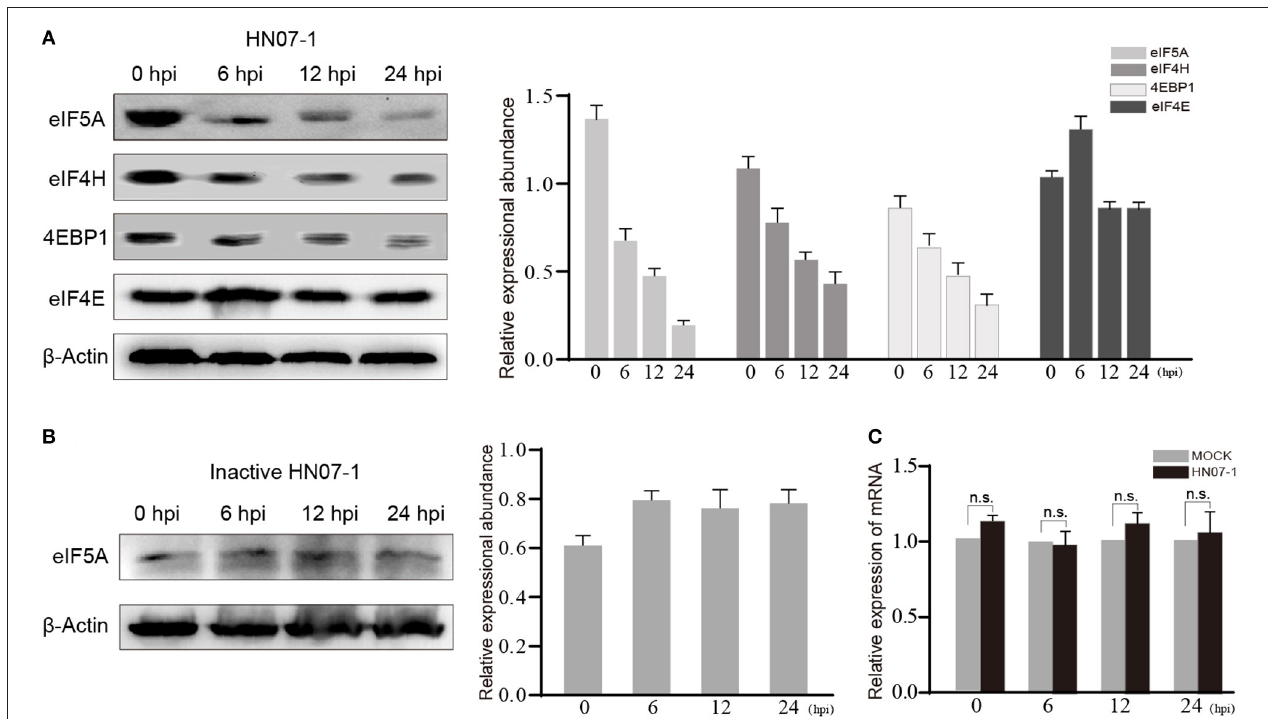
FIGURE 6 | The protein level of eIF5A was decreased after HP-PRRSV HN07-1 infection. (A) PAMs were infected with HP-PRRSV HN07-1 at MOI = 0.1 or mock-infected. The cells were collected at 0, 6, 12, and 24 hpi then total proteins of cells were analyzed via WB to measure protein levels of eIF5A, 4EBP1, eIF4H, and eIF4E. (B) PAMs were treated with UV-inactivated PRRSV then the cells were harvested at 0, 6, 12, and 24 hpi, then total proteins from cells were analyzed via WB to measure protein levels of eIF5A. (C) PAMs were infected with HP-PRRSV HN07-1 at MOI = 0.1 or mock-infected. The cells were collected at 0, 6, 12, and 24 hpi then total RNA preparations from the cells were analyzed via RT-PCR to detect transcription-level expression of